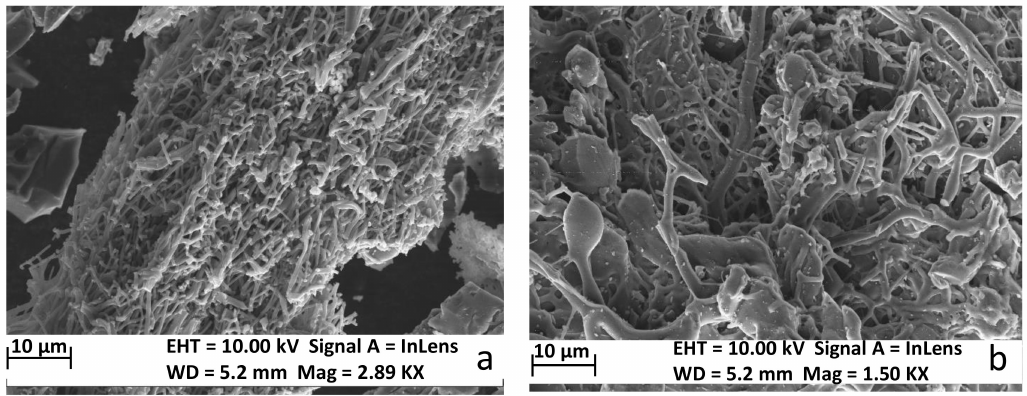
Figure 1. SEM micrographs of the electrospun fibers treated at: ( a ) 1200 ◦ C; ( b ) 1300 ◦ C.